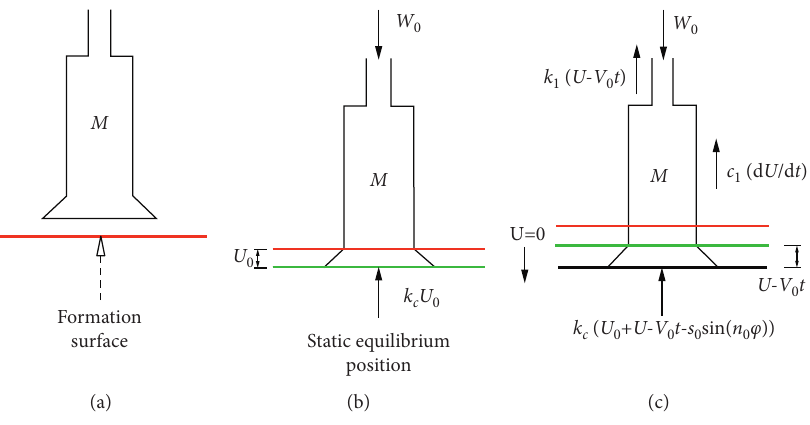
Figure 2: Different states of bit-rock